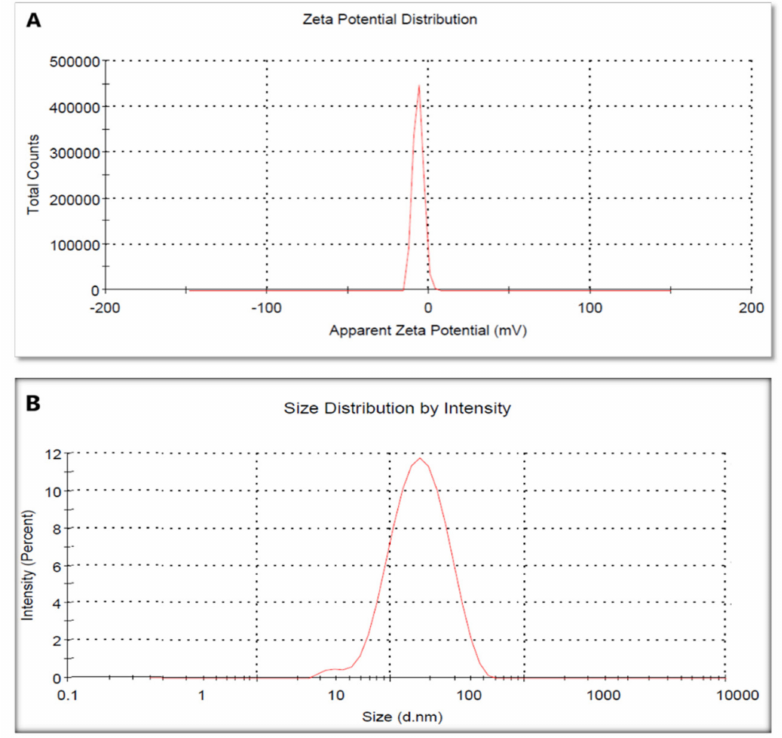
Figure 5. Zeta potential analysis ( A ) and DLS ( B ) of the biosynthesized AgNPs by